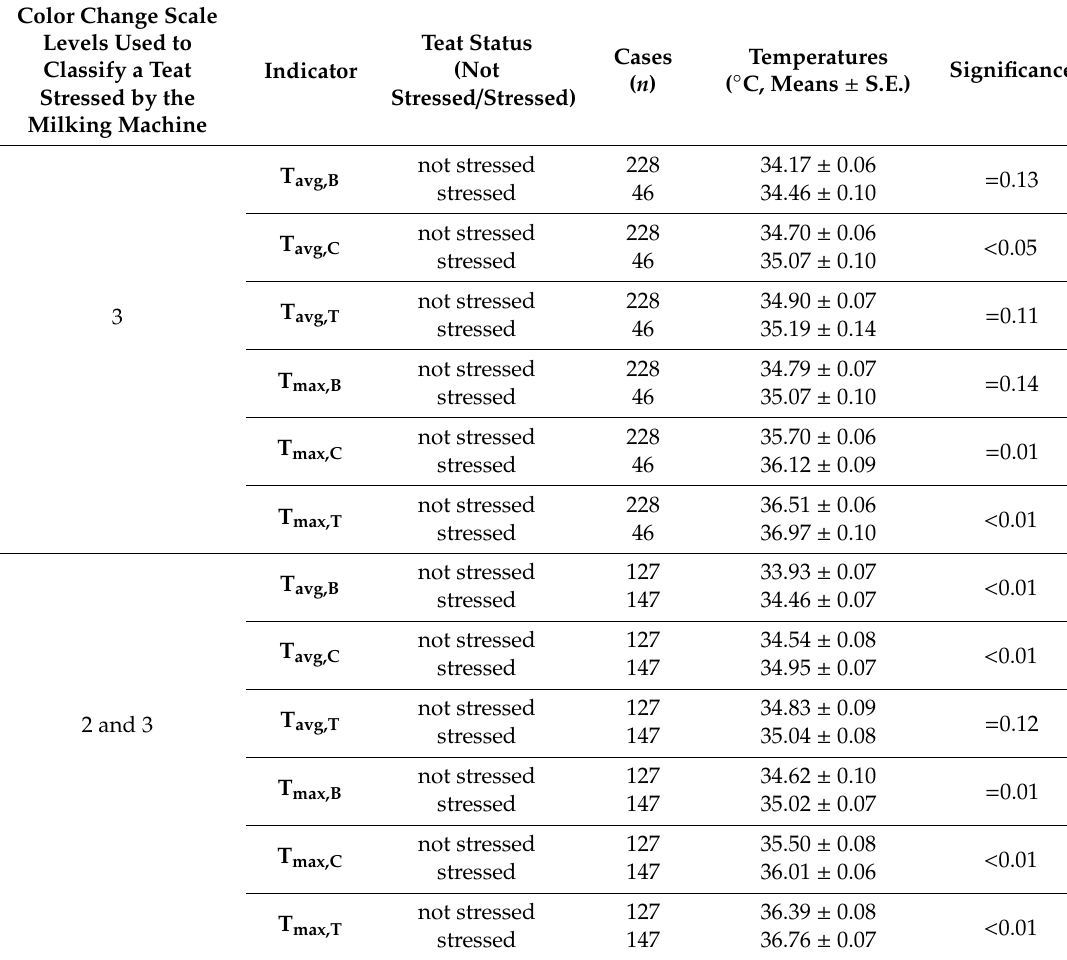
Table 3. Descriptive statistics of the indicators investigated (T avg,B , T avg,C , T avg,T , T max,B , T max,C , and T max,T ) in terms of mean and standard error values (S.E.) for each criterion adopted to classify the teat status (i.e., criterion 1: teat = “stressed” if the scoring of the teat fell in the level “three” of the color change scale adopted to classify each teat after the end of milking; criterion 2: teat = “stressed” if the scoring of the teat fell within the level “two” or “three” of the color scale